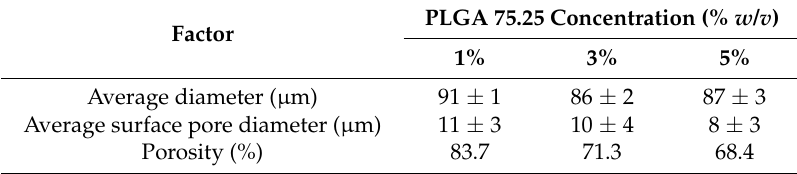
Figure 3. Scanning electron microscope (SEM) images of poly(lactic- co -glycolic) acid (PLGA) porous microsphere particles fabricated by batch synthesis with increasing PLGA 75:25 concentrations (% w / v ), 1%, 3% and 5%. The scale bars are 100 µm. Table 1. Structure characterization of PLGA 75:25 microspheres obtained with increased polymer concentration, p < 0.05. The average diameters and porosity (%) were calculated based on SEM images with image analysis software ImageJ and weight ratios as depicted in Section 2.6.